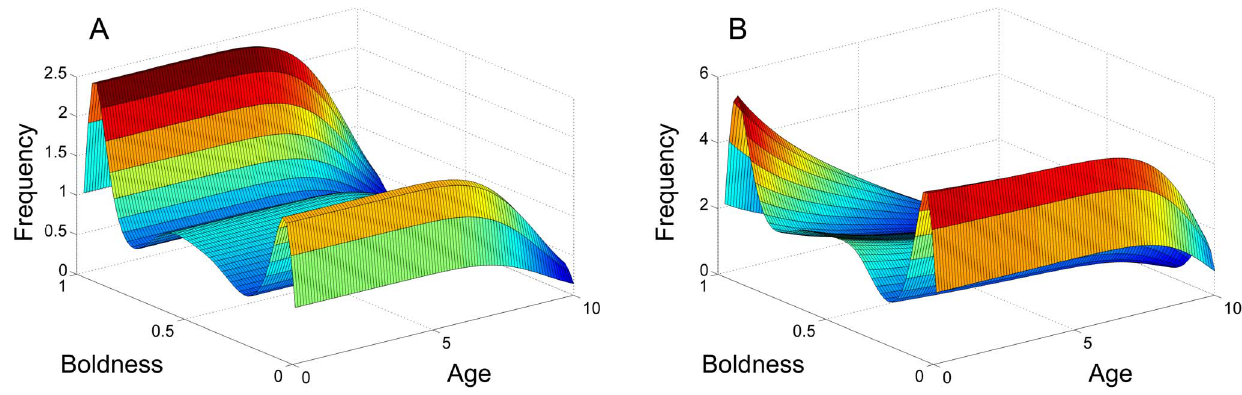
Figure 6. Comparing two different life-history trade-offs. Panel A and B show the case where there is only future versus current reproductive trade-off and only growth/reproductive success versus mortality trade-off respectively. Both panels are of the system at an equilibrium state.